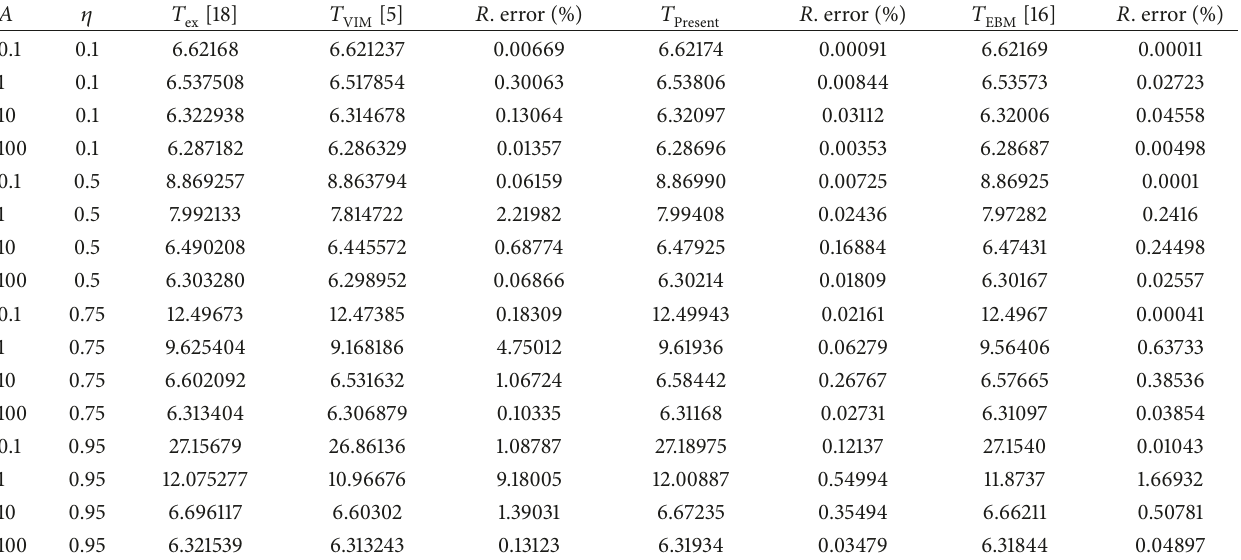
Table 4: Comparison of the approximate periods with the exact periods, Example